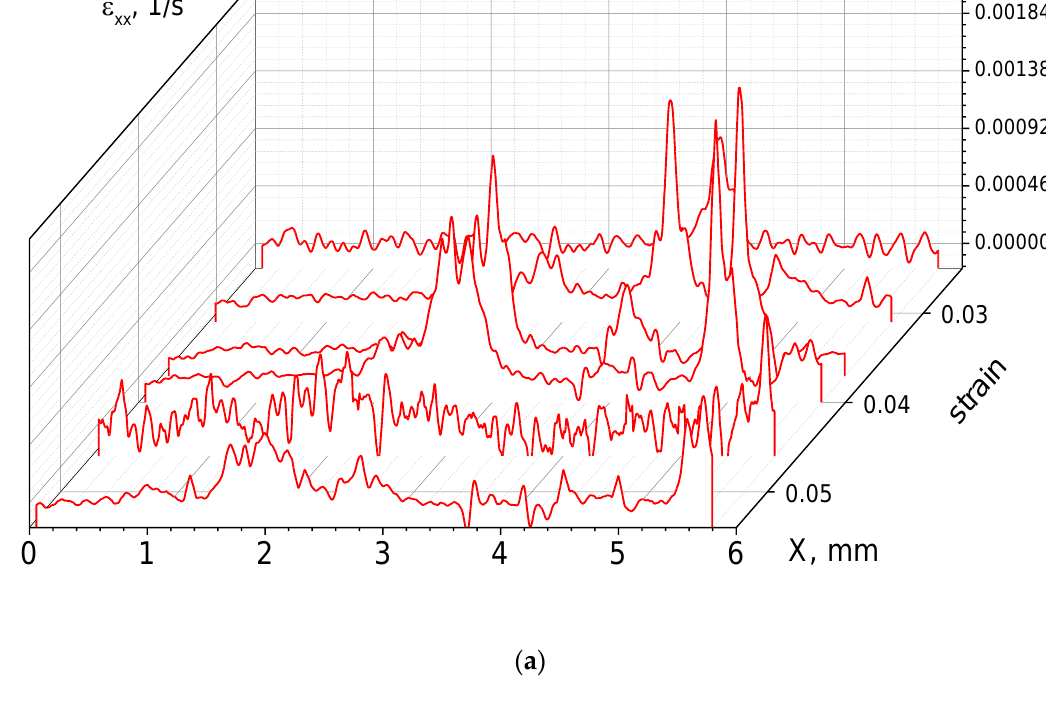
. ε yy ( Y , X = X m /2 ) ( b ). Data